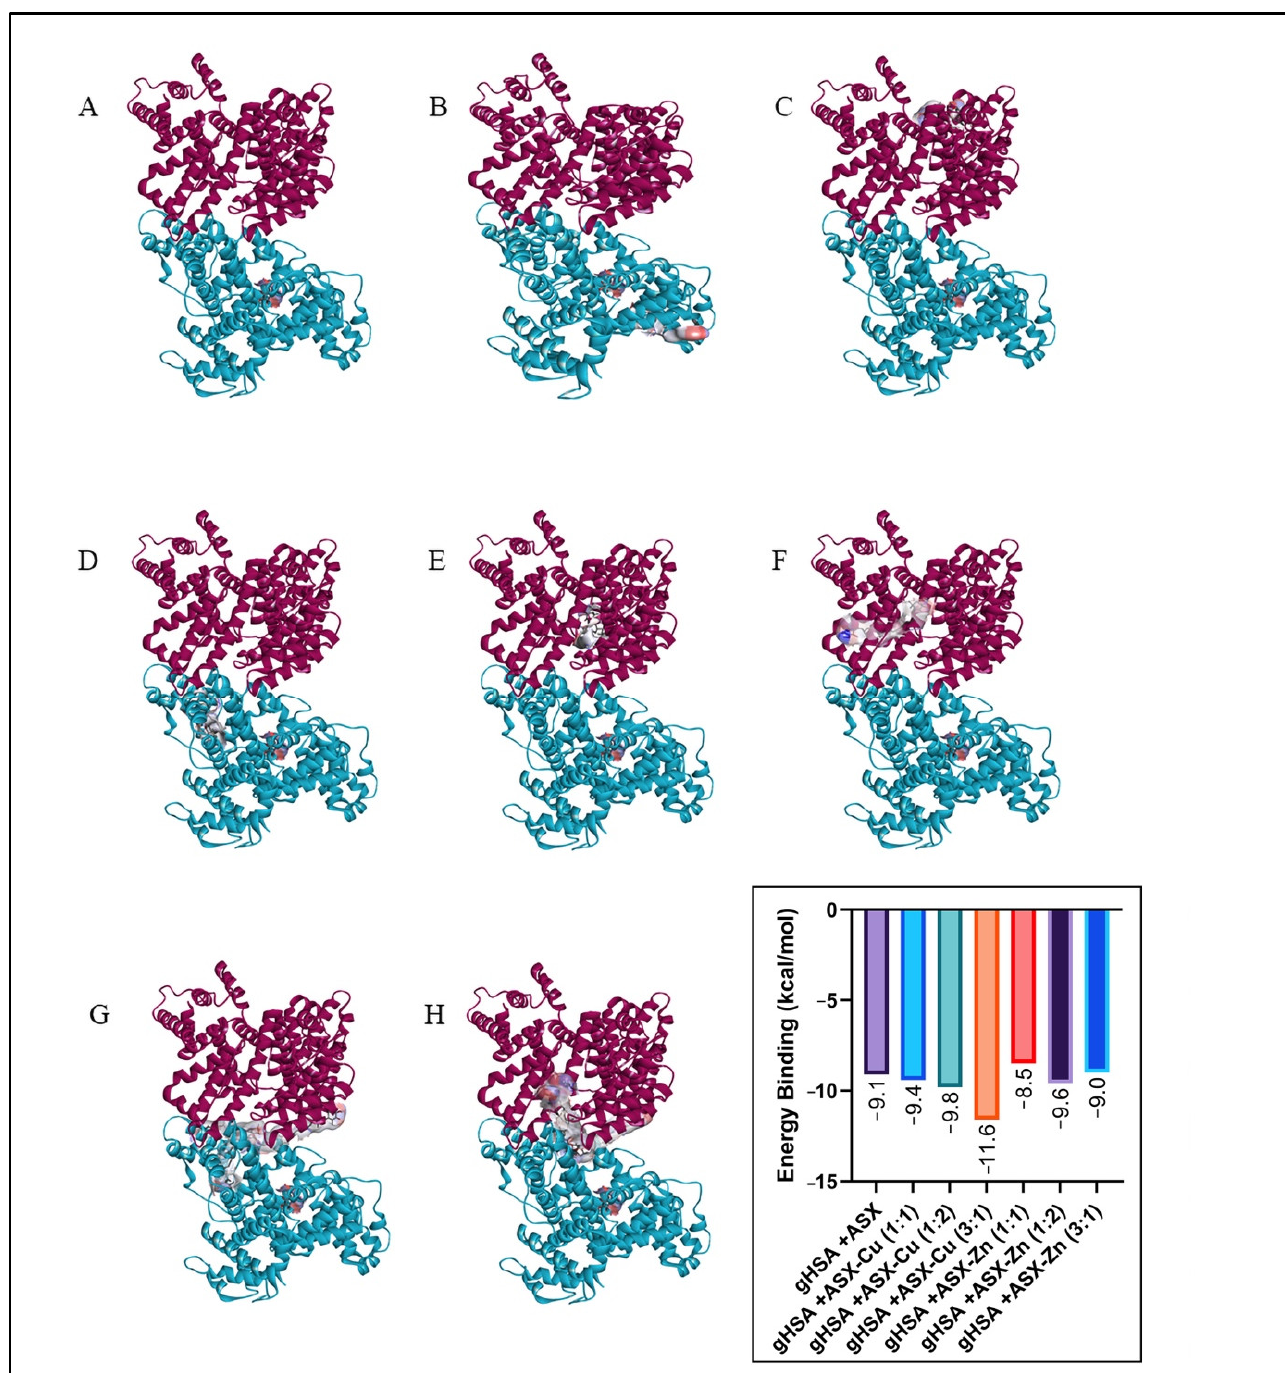
Figure 9. Docking results for ASX/ASX-metal ions with HSA ( A ) gHSA, ( B ) gHSA+ASX, ( C ) gHSA+ASX-Cu (1:1), ( D ) gHSA+ASX-Cu (1:2), ( E ) gHSA+ASX-Zn (1:1), ( F ) gHSA+ASX-Zn (1:2), ( G ) gHSA+ASX-Cu (3:1) and ( H ) gHSA+ASX-Zn (3:1). From binding energy, we can conclude that ASX-metal ions are still better than ASX when binding into HSA, HSA+ASX (−8.6 kcal/mol), meanwhile HSA+ASX-Cu (3:1) (−11.2 kcal/mol) and HSA+ASX-Zn (3:1) is −10.4 kcal/mol. These findings support all the data for UV-Vis, CD-spectra, antioxidant activity by EPR, viscosity as well as zeta potential. Both ASX and ASX-metal ions interact more strongly with gHSA than HSA complex. Where in gHSA, ASX has a binding energy of −9.1 kcal/mol, while in HSA, it is −8.6 kcal/mol. Like- wise, the addition of metal ions Cu 2+ and Zn 2+ can increase the binding energy of ASX in gHSA protein.